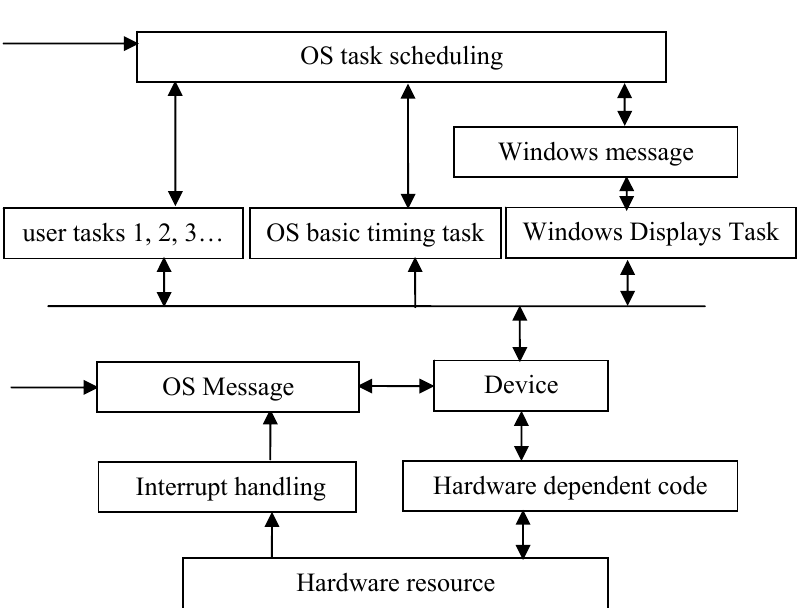
Figure 3. Architecture of ZKOS.